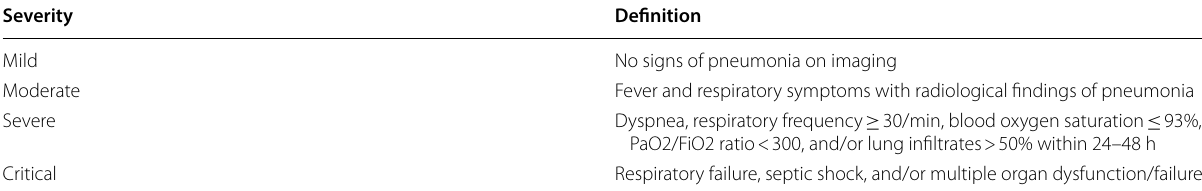
Table 1 The severity of the COVID-19 Severity